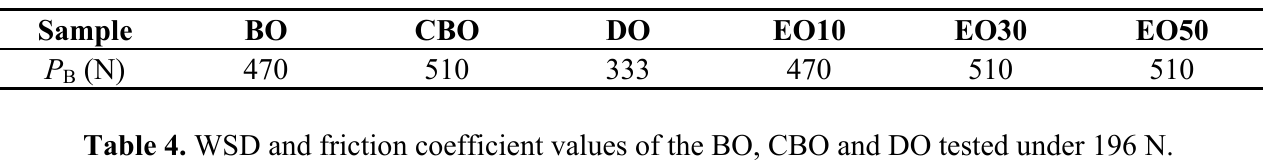
Table 3. P values of the oil samples. B